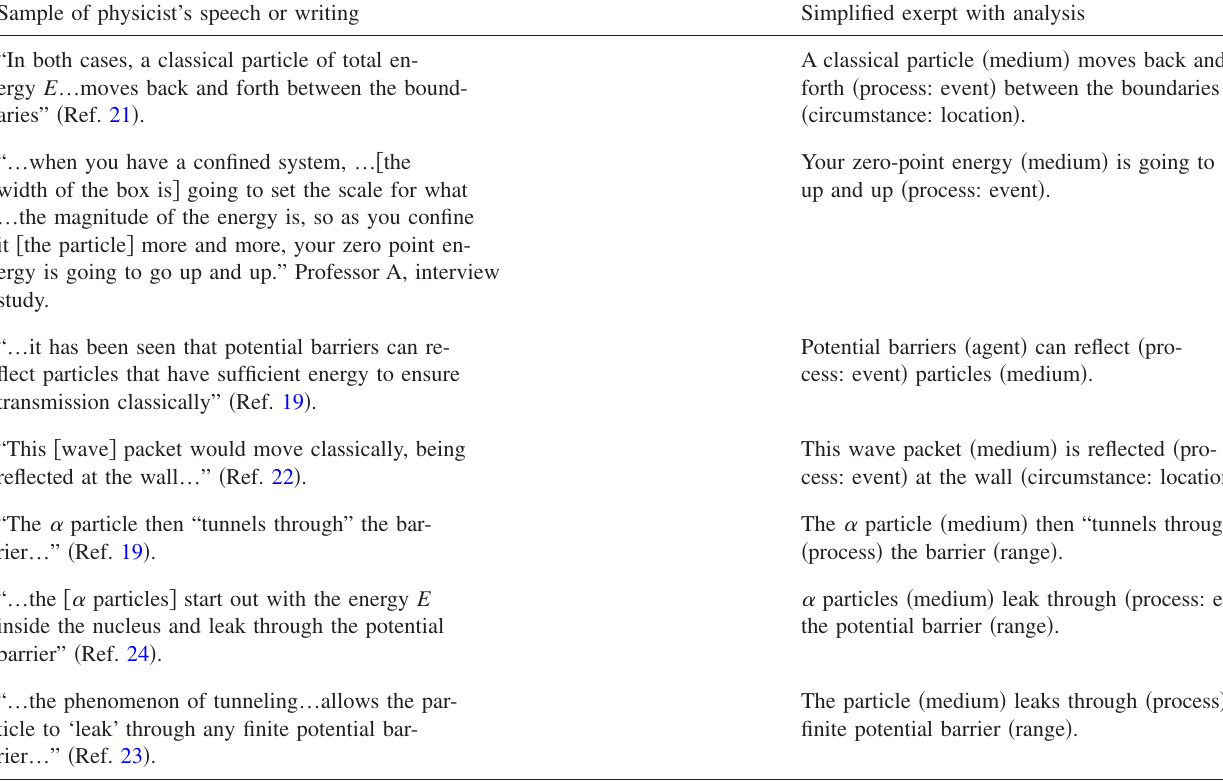
TABLE III. Samples of physicists’ speech and writing for grammatical